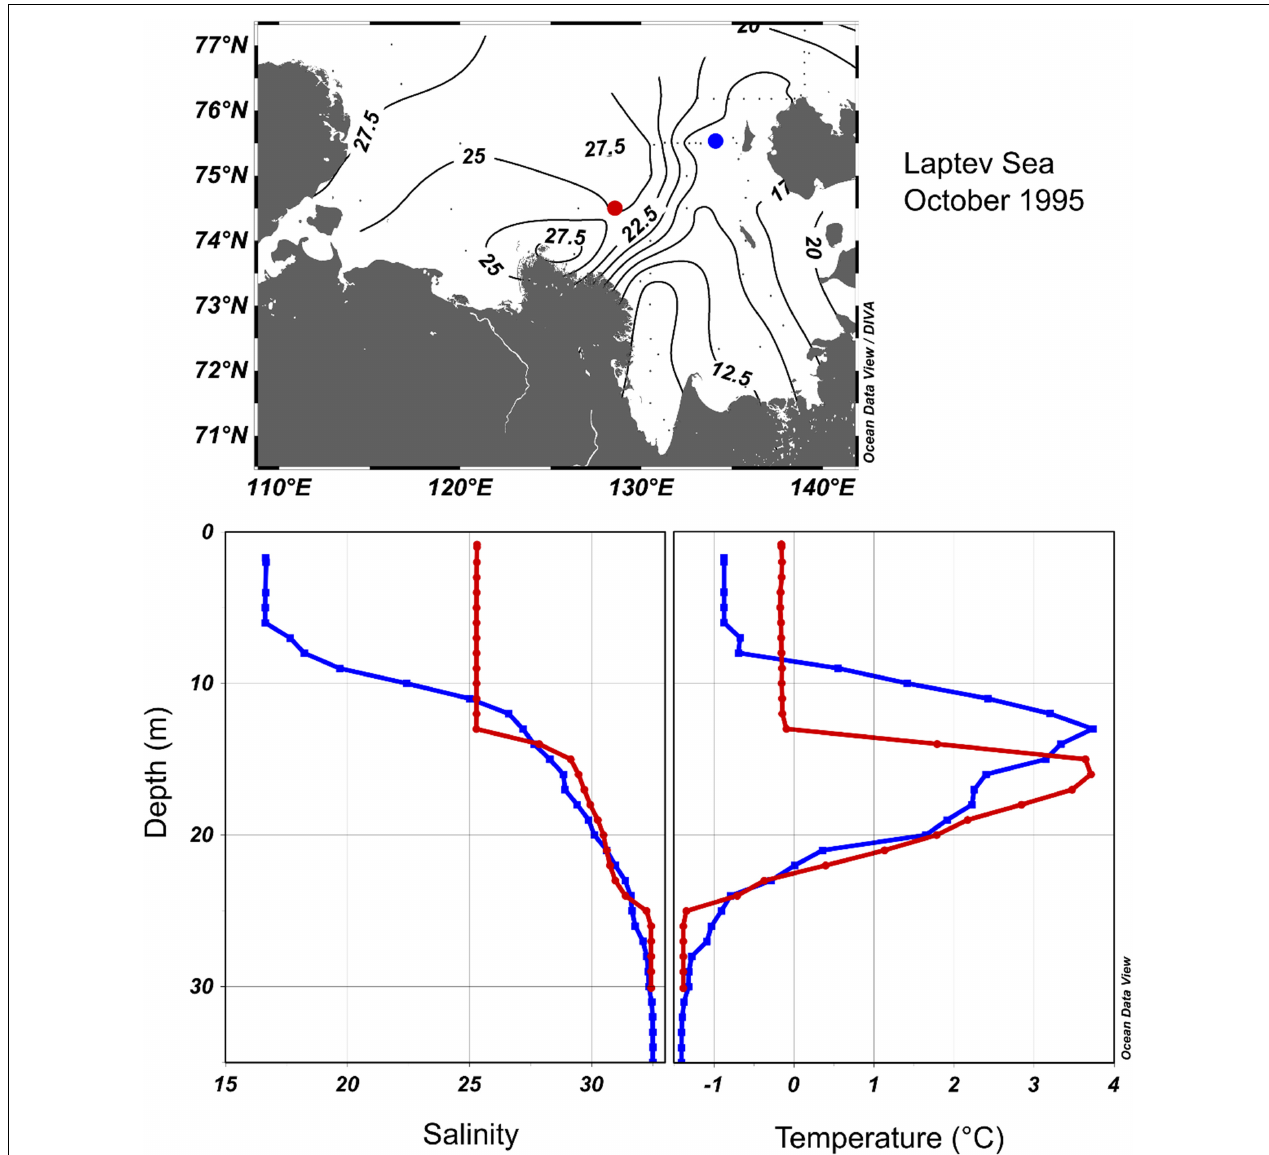
FIGURE 13 | Example from intermediate temperature maximum observed during a survey in October 1995. The map shows the surface salinity distribution and location of two CTD profiles, shown in the respective colors in the lower panels (left: salinity; right: